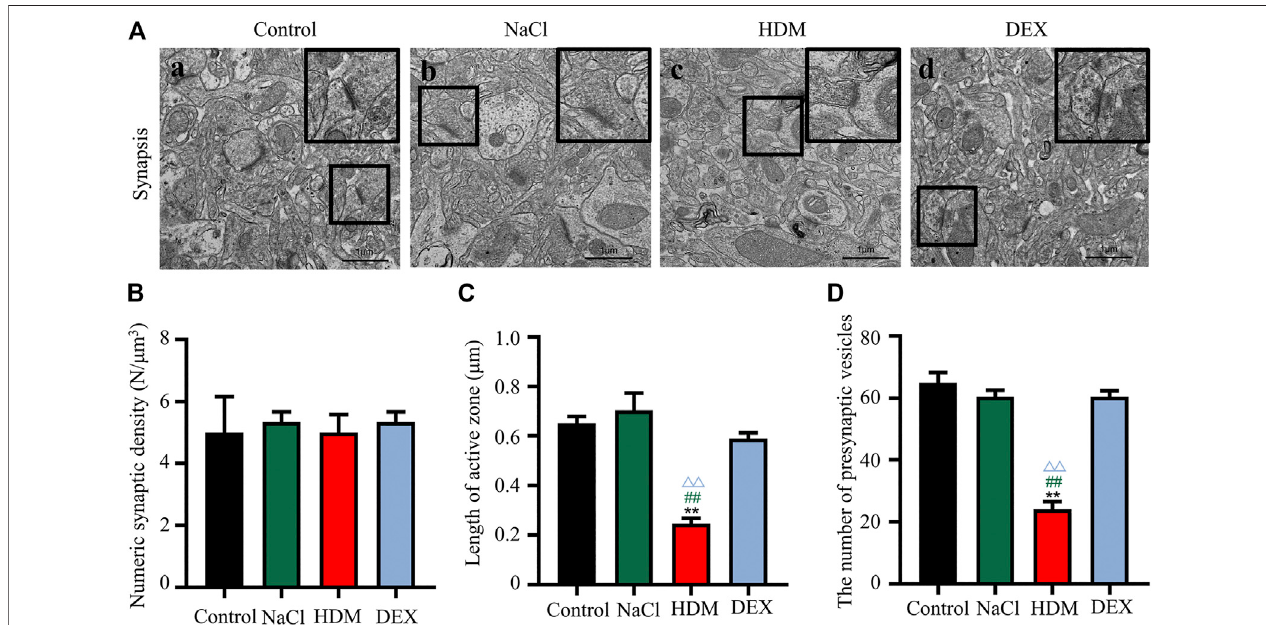
FIGURE 5 | The synaptic activity length and the number of vesicles decreased in the hippocampus and cortex of mice in the HDM group. [A(a – d)] Brain tissue hippocampal synapses. (B) Numeric synaptic density. (C) Synapse length of active zone (D) The number of presynaptic vesicles. n (cid:1) 5. ** p < 0.01 between HDM group and Control group. ## p < 0.01 between HDM group and NaCl group. △△ p < 0.01 between HDM group and DEX